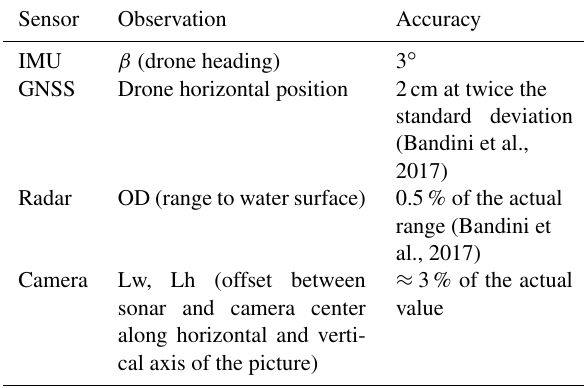
Table 2. Accuracy of the different sensors used to measure the ab- solute position of the